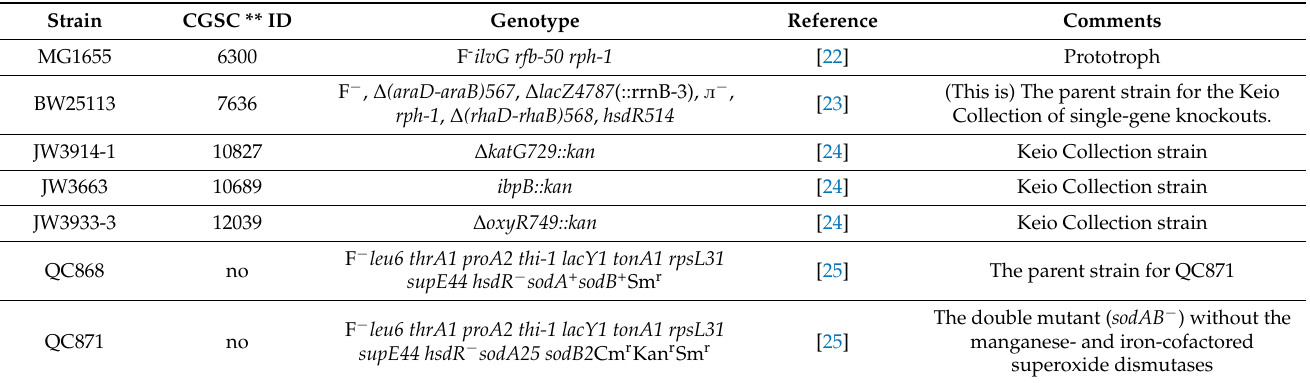
Table 1. Escherichia coli strains used in this